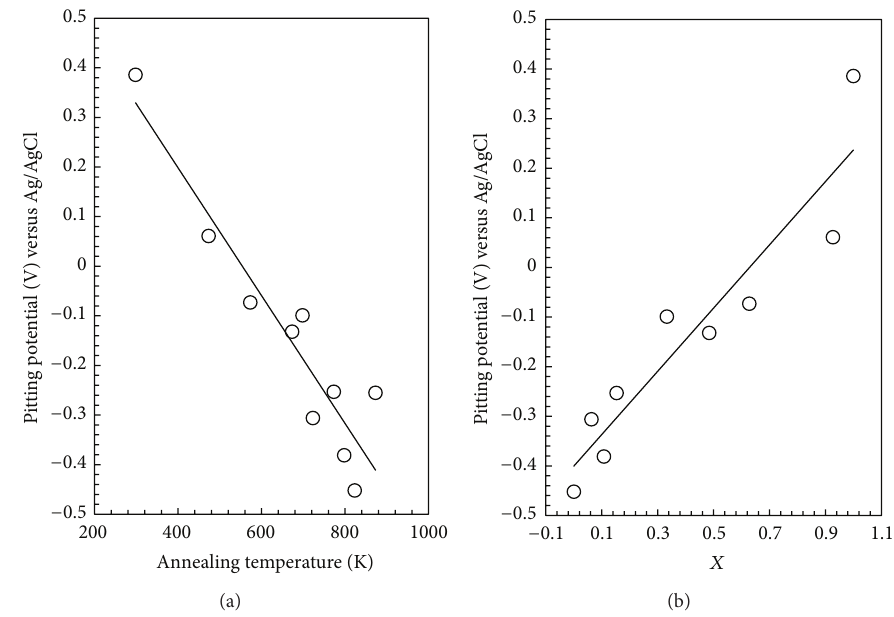
Figure 11: Relation between, (a) the pitting potential, 𝐸 𝑝 and annealing temperature and (b) 𝑋 parameter.